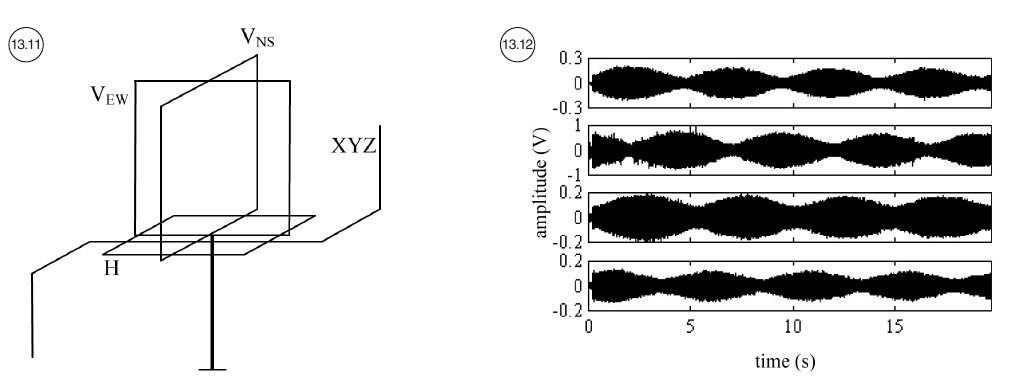
Fig. 13.11. Schematic of the collocated array actually used (4 antennas). Fig. 13.12. Signals received by the array (V EW , V NS , H,